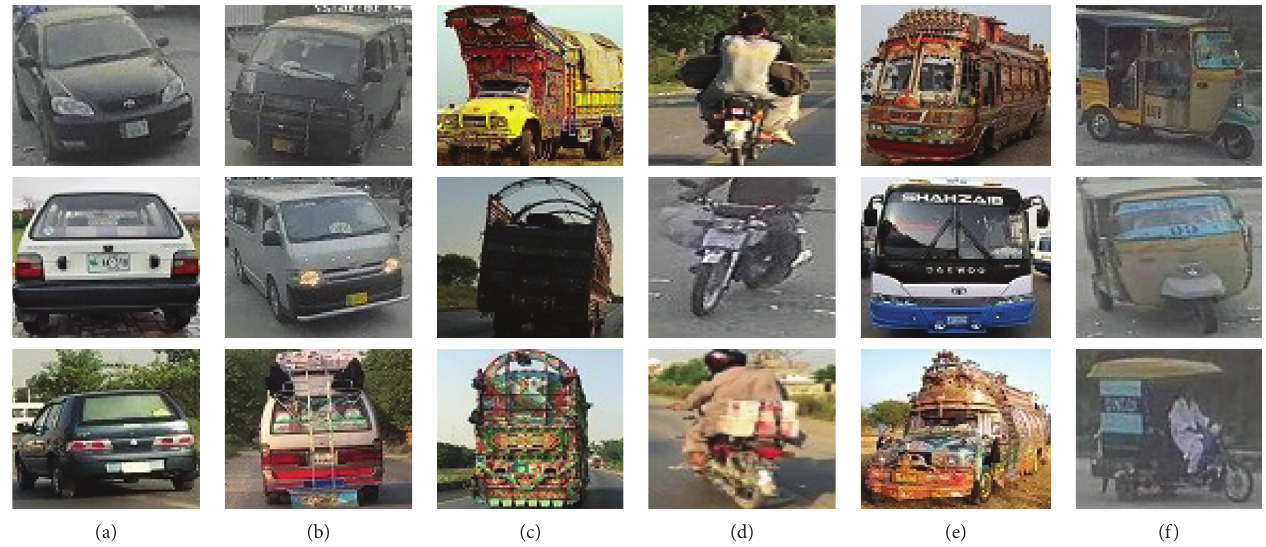
Figure 2: Sample dataset images representing each class: (a) car, (b) van, (c) truck, (d) motorbike, (e) bus, and (f)